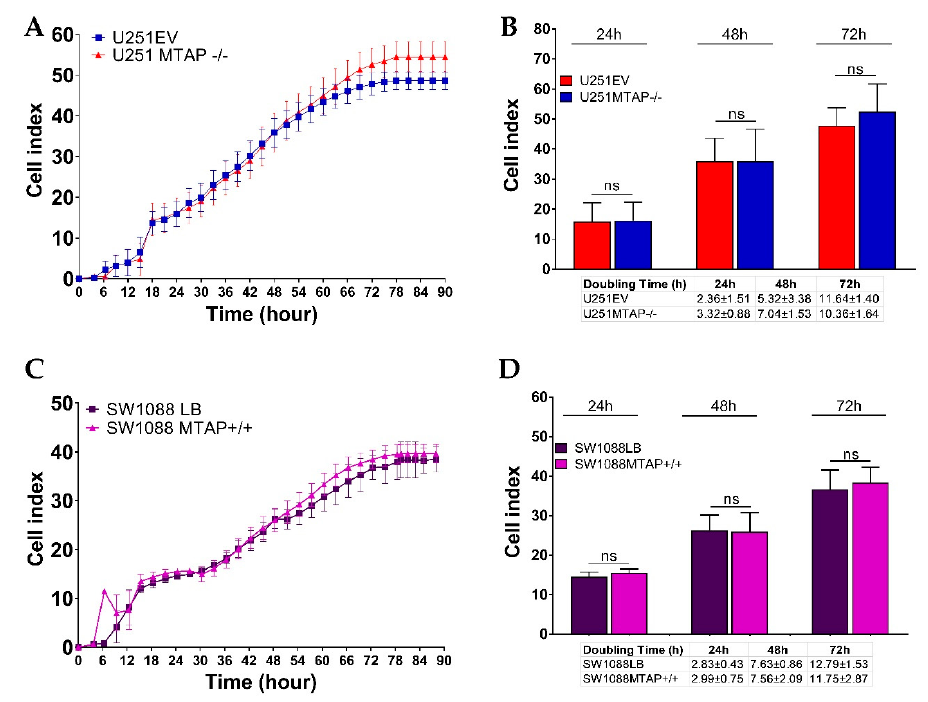
Figure 6. Dynamic monitoring of cell proliferation using impedance technology. Cell index values representative for U251MTAP − / − vs. U251EV ( A ) and SW1088MTAP +/+ vs. SW1088LB ( C ) measured by the Real Time Cell Analysis (RTCA) assay for 90 h. Plot representative of cell index and doubling time at 24, 48, and 72 h for U251MTAP − / − vs. U251EV ( B ) and SW1088MTAP +/+ vs. SW1088LB ( D ). Plot representative of three independent experiments. Student t-test: * p < 0.05, ** p < 0.01, *** p < 0.001, ns : not